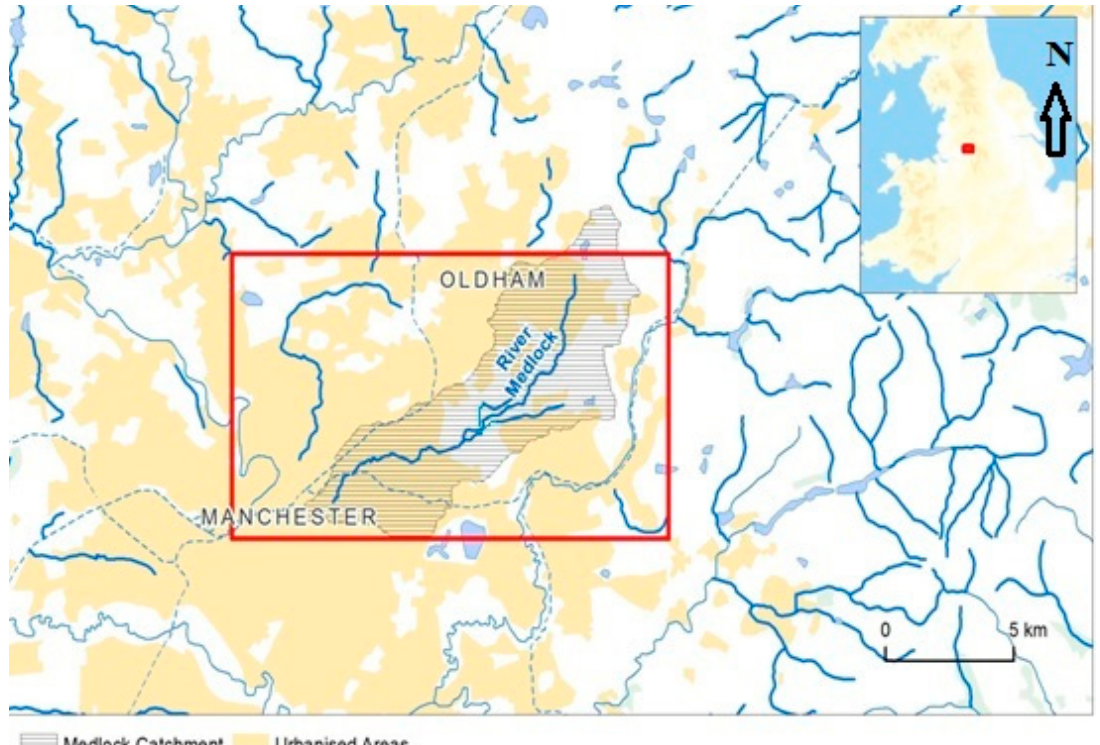
Figure 1. River Medlock, Greater Manchester, showing catchment boundary with urban settlements. Inset: Map of the U.K. with the location of Greater